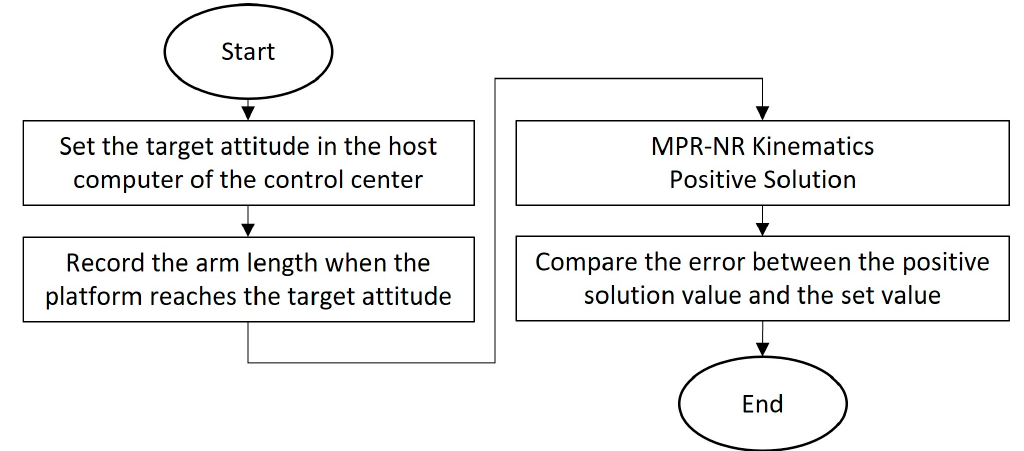
Figure 6. Flowchart of physical test experiment.